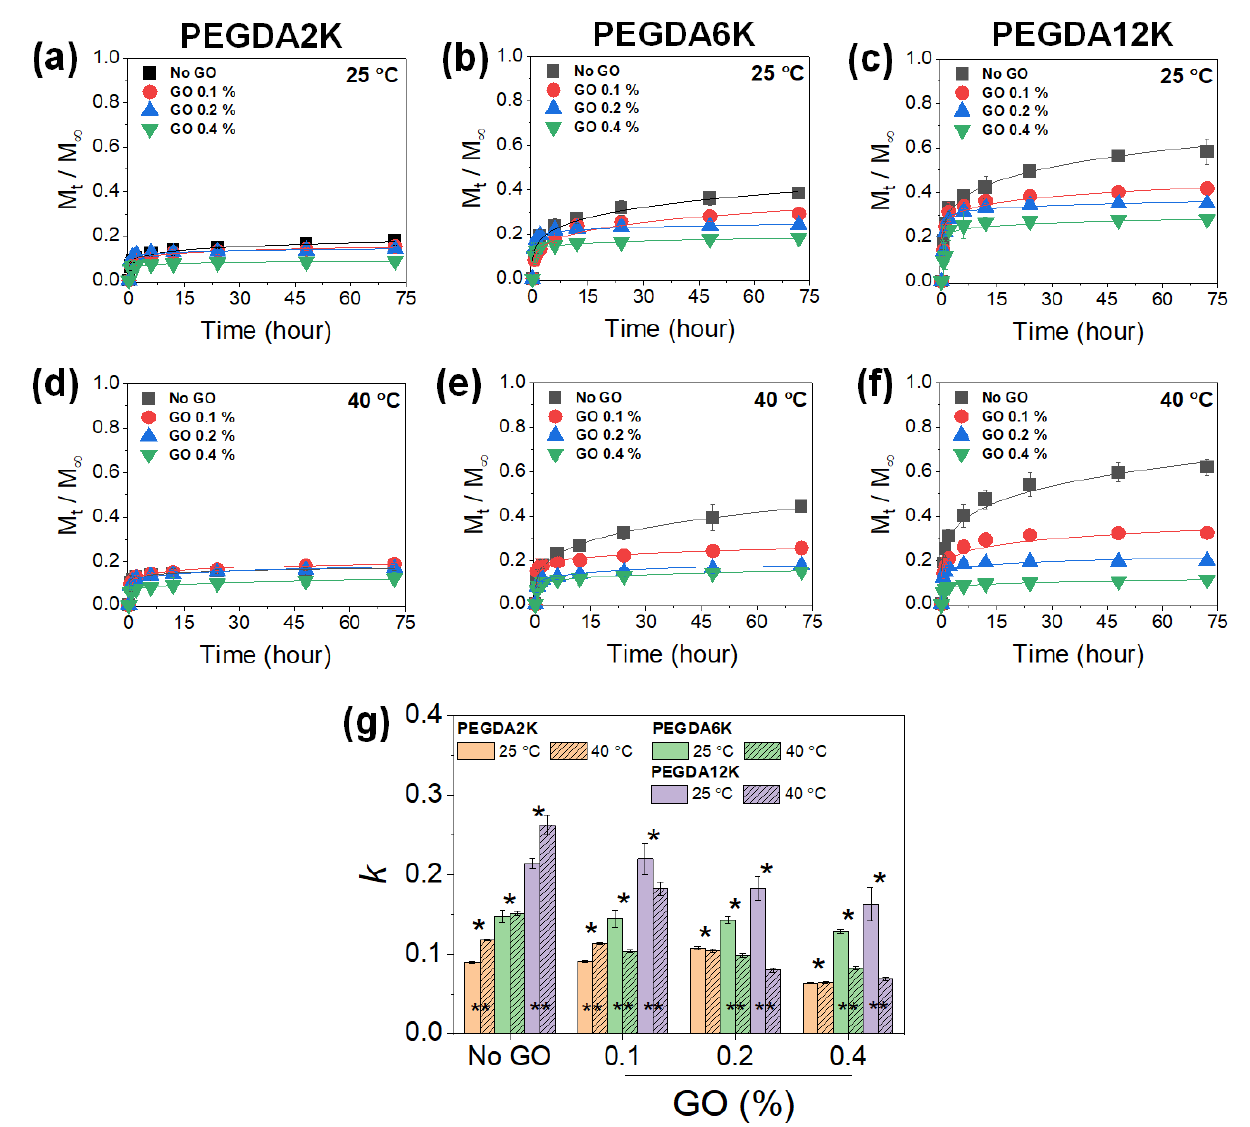
Figure 4. Cumulative release ( M t / M ∞ ) profiles of BSA released from PEG-PNIPAm hydrogels with varying M W of PEGDA and GO concentration measured at 25 ◦ C or 40 ◦ C: ( a , d ) PEGDA2K, ( b , e ) PEGDA6K, and ( c , f ) PEGDA12K. The concentration of PEGDA was 10%. ( g ) Release kinetic constants ( k ) were obtained by fitting the profiles with Equation (1) (* p < 0.05 compared between different M W ’s of PEGDA, ** p < 0.05 compared between 25 ◦ C and 40 ◦ C, n = 10).